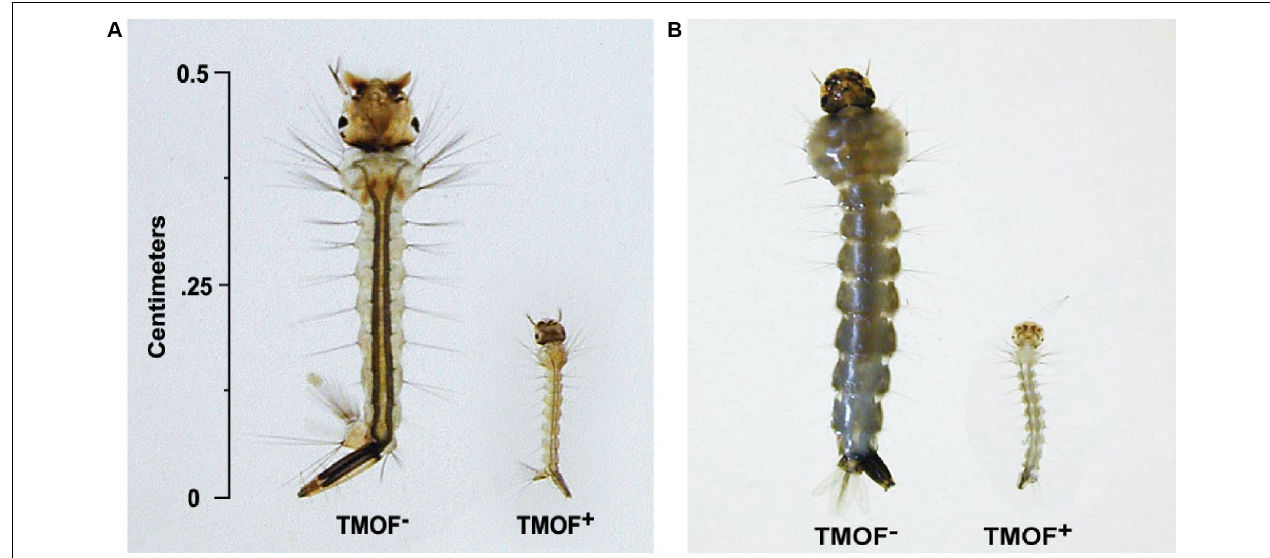
FIGURE 10 | Cx. quinquefasciatus (A) and Ae. aegypti (B) larvae were fed P. pastoris cells KM71H TMOF − (control) and KM71H- tmf A cells TMOF + for 4 days. Larvae that fed the recombinant cells expressing TMOF did not grow because they cannot digest their